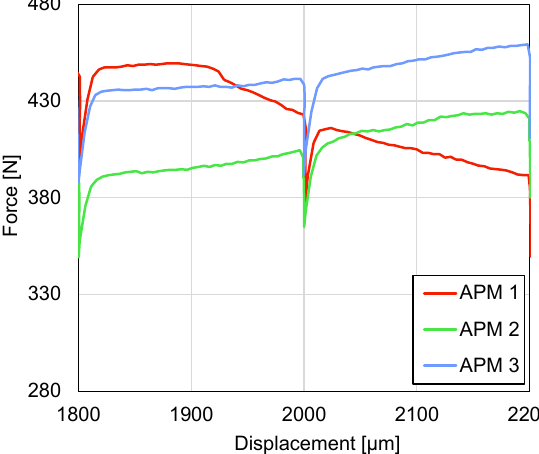
Figure 9. Force recovery in a single loading step.